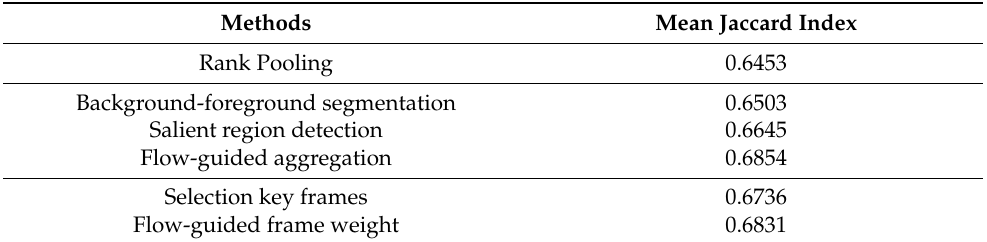
Table 2. Comparison of recognition accuracy using rank pooling and weighted rank pooling on the validation set of ChaLearn LAP ConGD